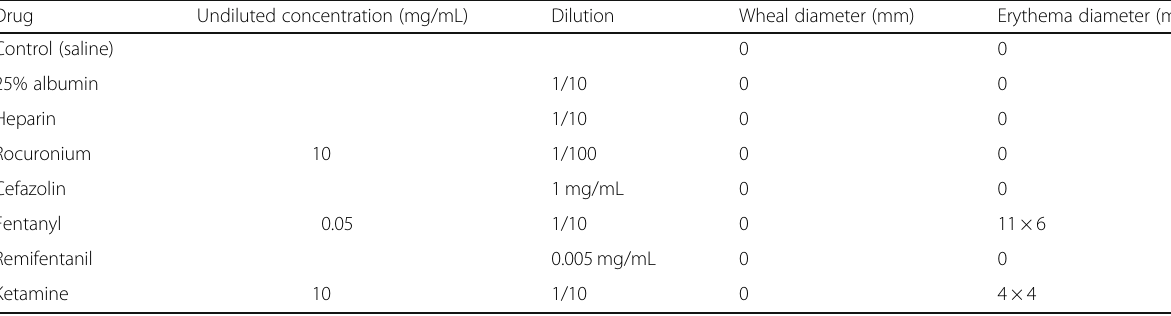
Table 1 Intradermal test for the drugs given during the anaphylactic event